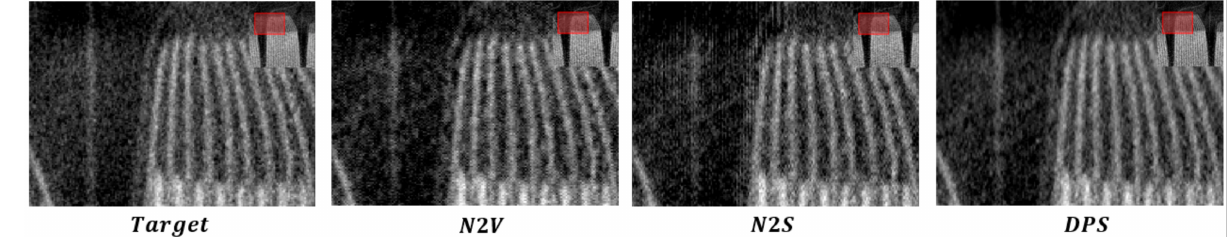
Figure 6. Artifacts in the results of the counterpart deep learning-based methods. All images are in the coronal view. Red boxes in the images indicate the expanded regions.